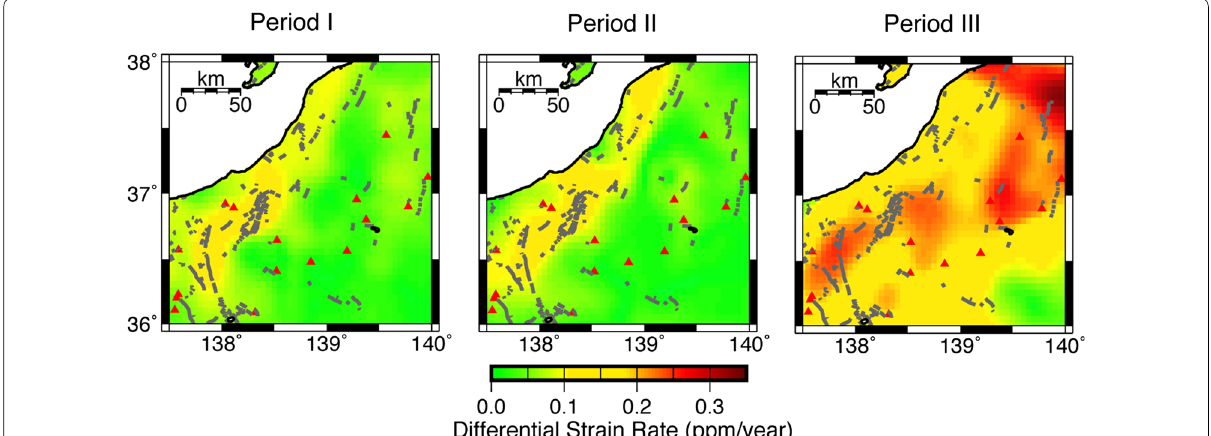
Fig. 7 Spatial distributions of the differential strain rate in left panel the period I, middle panel the period II, and right panel the period III (taken from Dojo and Hiramatsu 2017). Gray lines show Quaternary active faults, and red triangles show Quaternary active